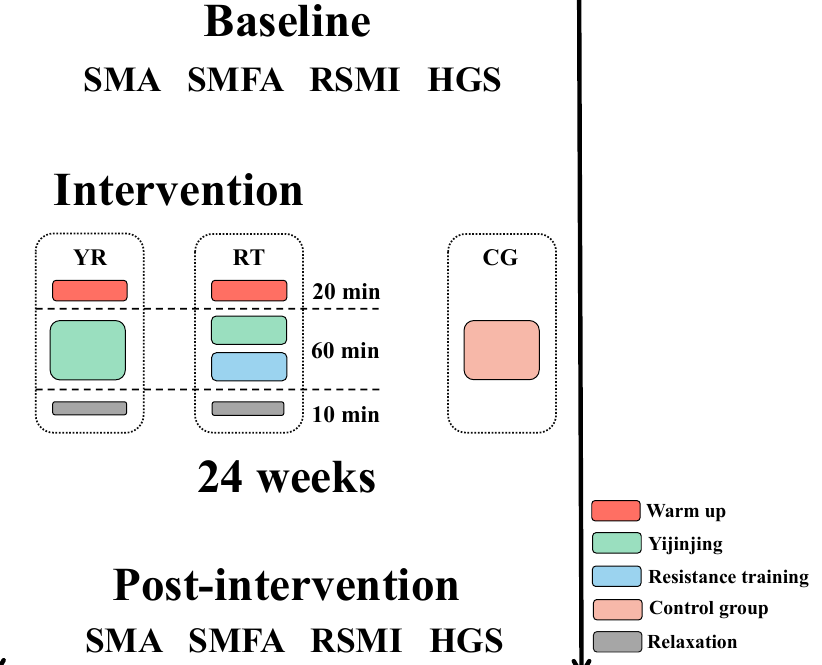
Figure 2. Experimental design. All participants were randomly allocated to the YR, RT, and CG intervention groups. Assessment of participant’s skeletal muscle cross-sectional area at the 3rd lumbar vertebra (L3 SMA), skeletal muscle interstitial fat area at the 3rd lumbar vertebra (L3 SMFA), relative skeletal muscle mass index (RSMI), and handgrip strength (HGS) at pre-intervention and post-